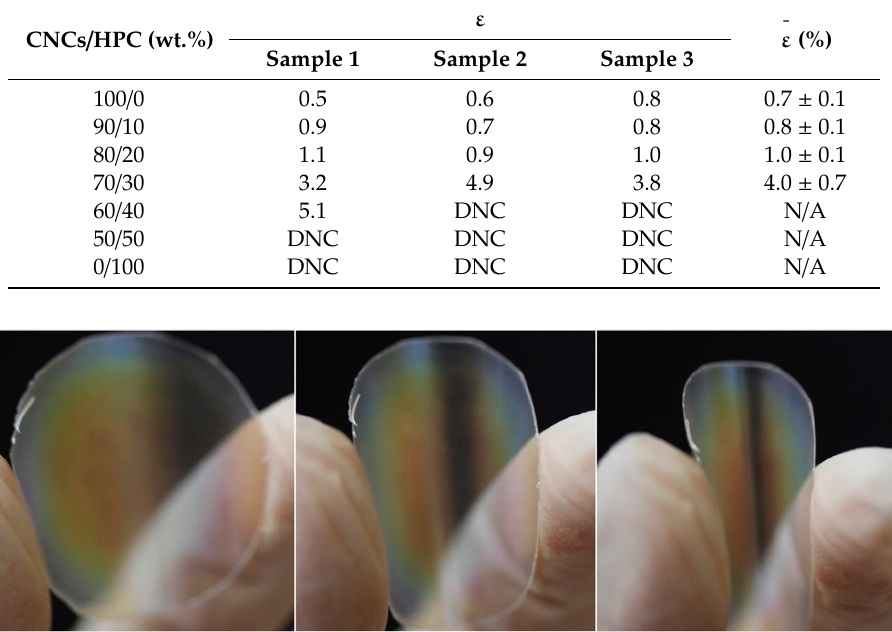
Table 1. Strain and strain average values, given in percentage, determined with Equation (2) for each tested sample. DNC = Did not crack; N / A = not applicable. ε CNCs / HPC (wt.%)